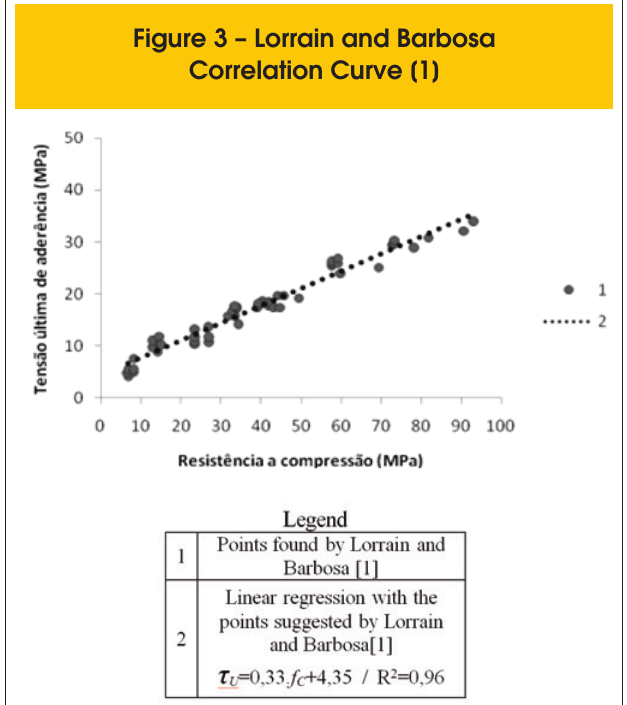
Figure 3 – Lorrain and Barbosa Correlation Curve